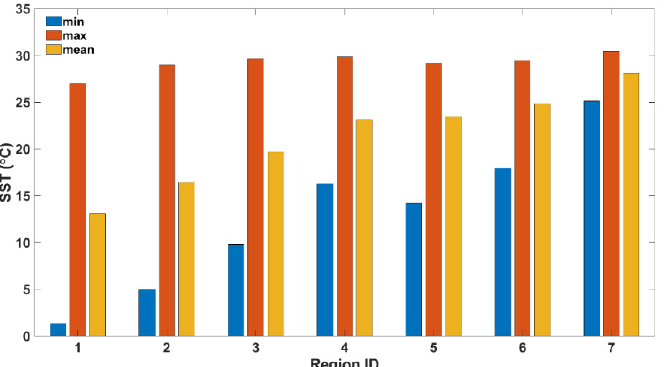
Figure 10. Statistics of monthly mean SST including minimum, maximum, and mean value for different parts of China’s Surrounding Seas during 1979–2021.